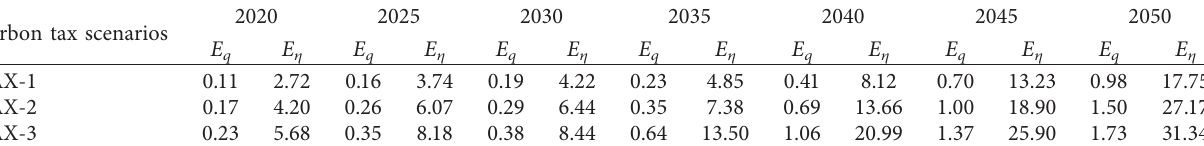
Table 4: Emission reduction potential and emission reduction rate of power industry.